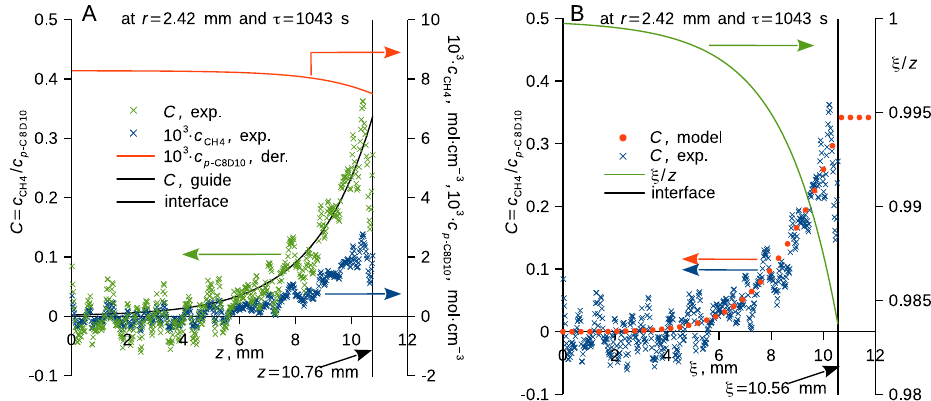
Figure 3. ( A ) Experimental relative ( C ) and mole ( c ) concentrations of methane, and the derived mole concentration of p -xylene (orange curve) are plotted against the depth coordinate ( z ) together with a guide for the eye (black curve) used for the extrapolation to the interface. ( B ) Experimental (blue crosses) and modelled (orange points, Fick’s second law) relative concentrations of methane are plotted against the B-fixed depth coordinate ( ξ ) together with the ξ/ z ratio (green curve). Phase interface is indicated by vertical dashed lines, both figures are for supercooled perdeuterated p -xylene ( p -C 8 D 10 ) at 7.0 ± 0.2 °C initially exposed to methane at 100.4 ± 0.2 bar, radius coordinate and time upon pressurization are indicated.